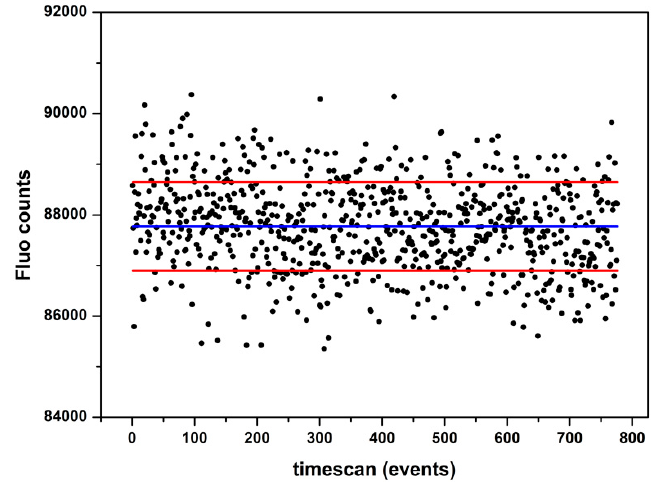
Figure 5. Determination of the noise at the 24,370 eV, the selected energy for the quantification of palladium speciation.